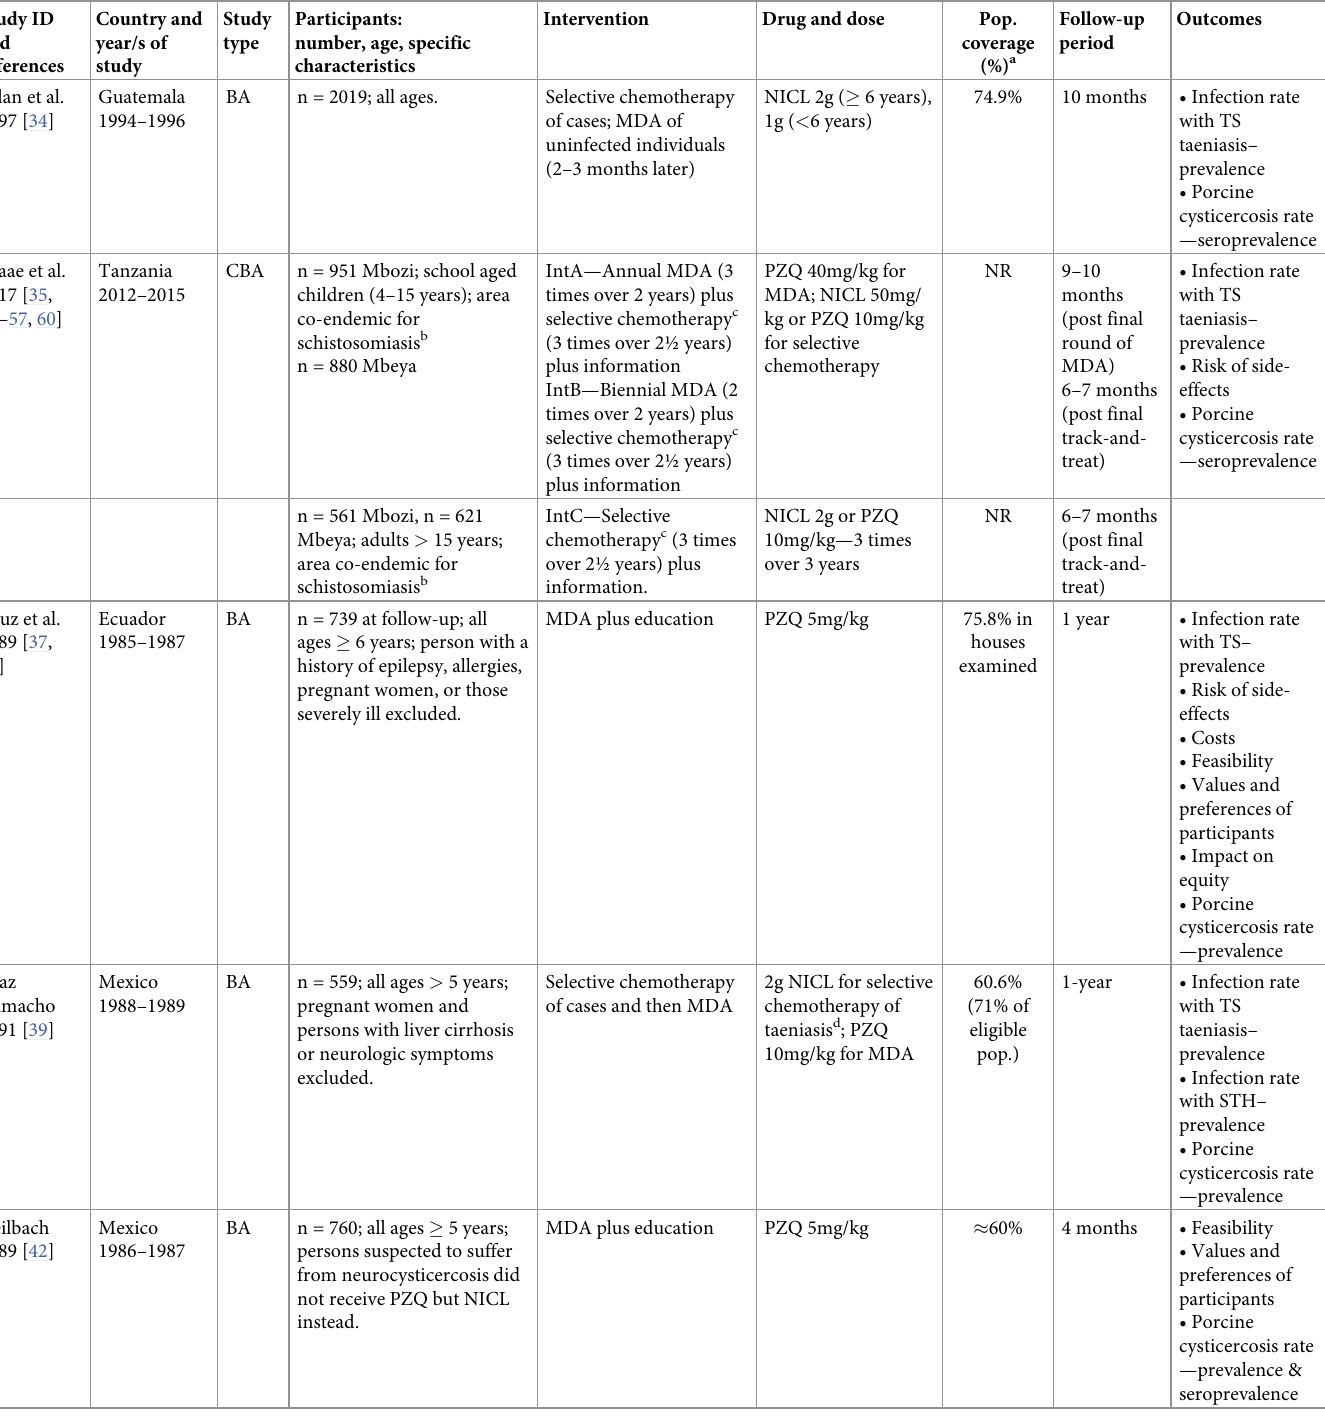
Table 1. Characteristics of included studies that tested Mass Drug Administration–with or without selective chemotherapy (n =